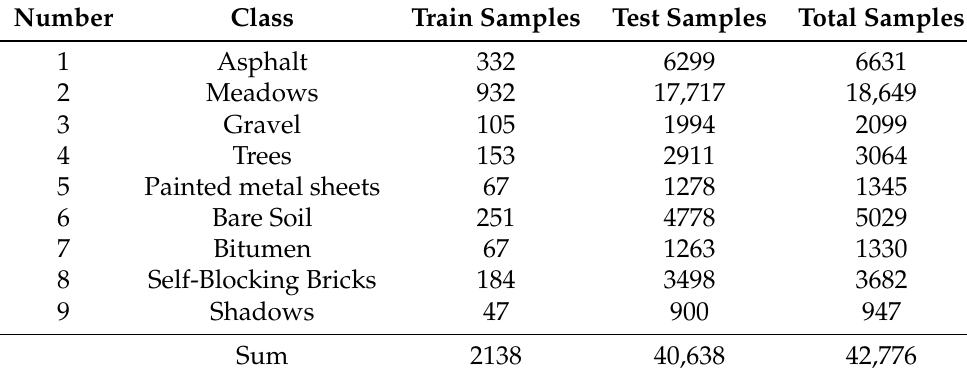
Table 2. The number of samples in the UP